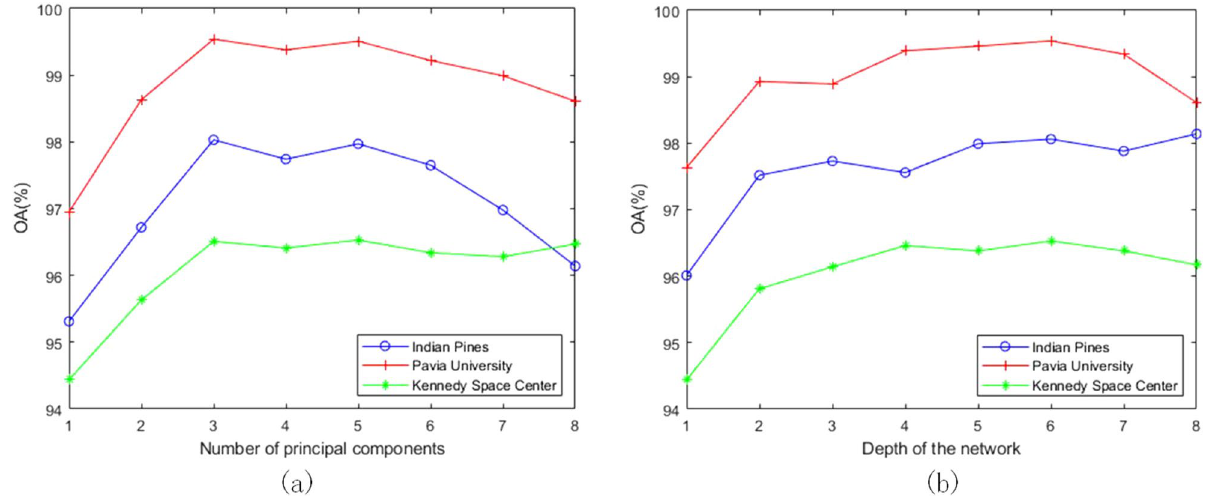
Figure 6. Effect of number of principal components and number of network layers on classification accuracy on three datasets. ( a ) Number of principal components; ( b ) Network layers.